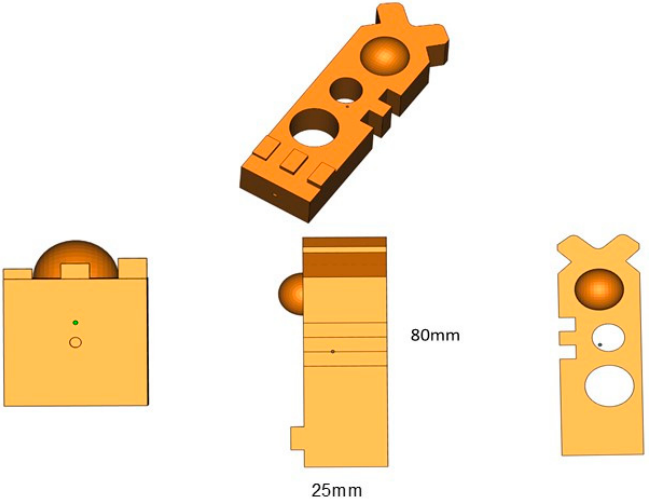
Figure 6. The resultant additive manufactured (AM) artefact design features.